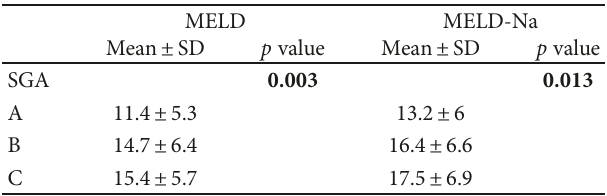
Table 3: Comparisons between mean MELD and MELD-Na scores among SGA classes.